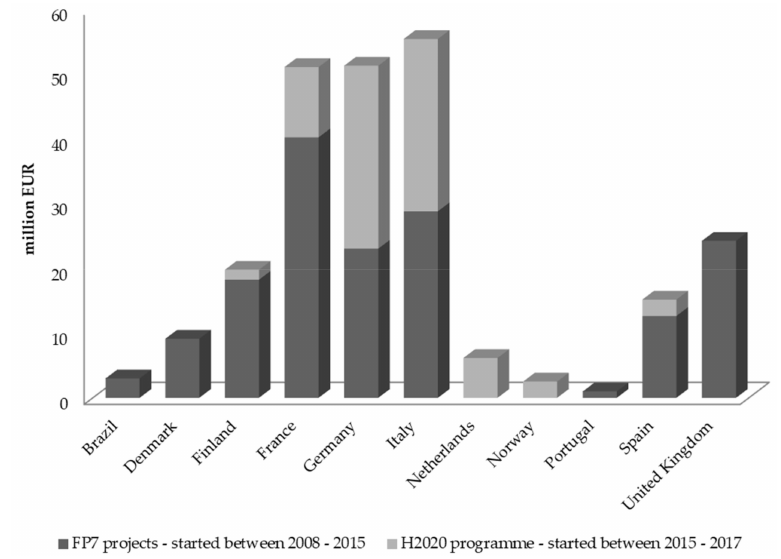
Figure 4. Total amount of EU funding by project coordinator